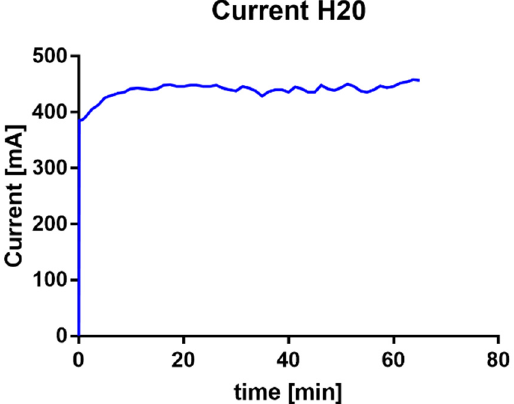
Figure 7. Current measured during experiment with 20 μ L of aqueous solution.